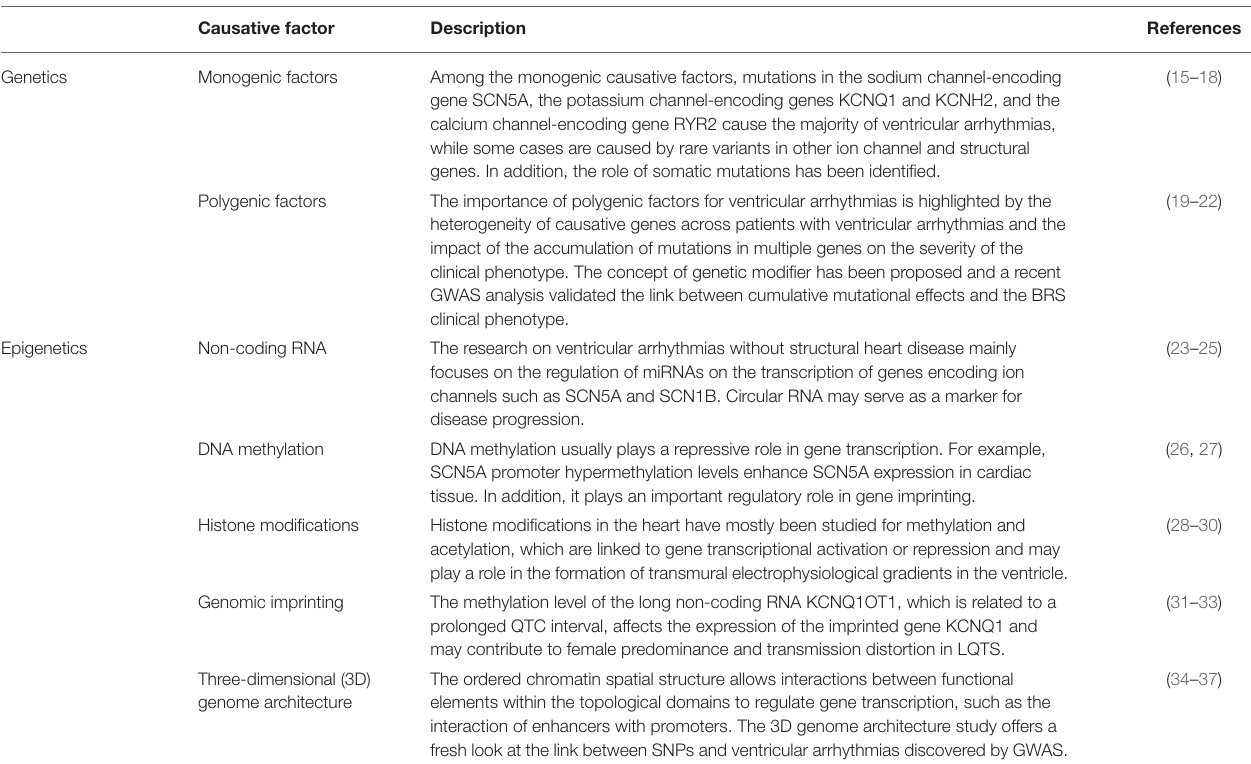
TABLE 1 | A brief description of the genetics and epigenetics of ventricular arrhythmias in non-structural heart